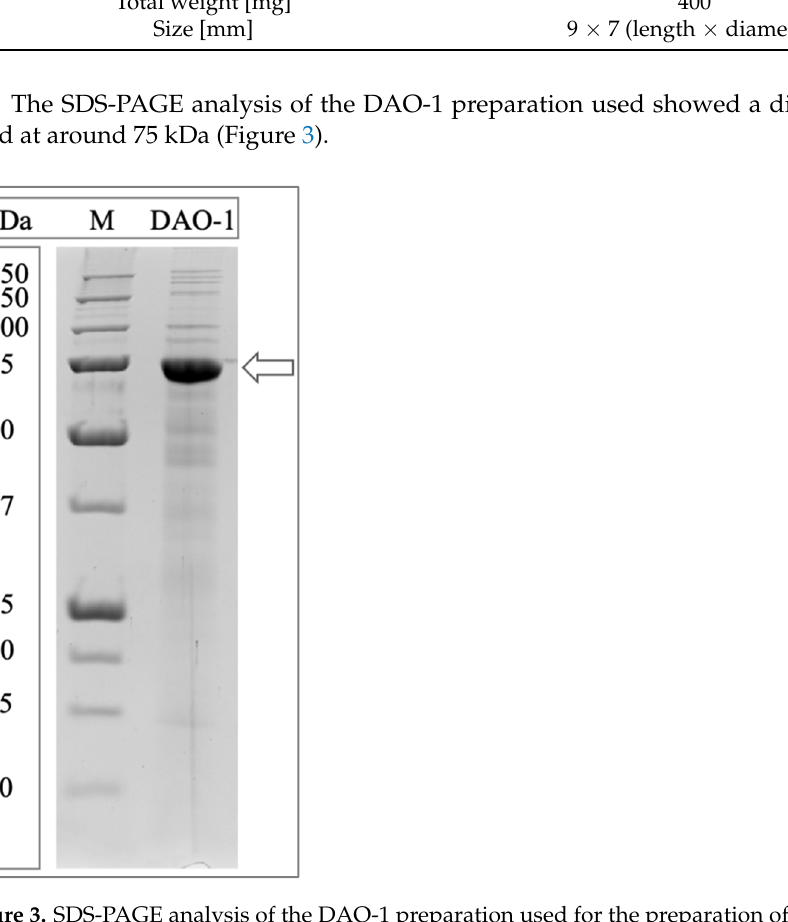
Figure 3. SDS-PAGE analysis of the DAO-1 preparation used for the preparation of DAO-1 tablets. Precision Plus Protein™ unstained protein standard 10–250 kDa (M). Arrow indicates the DAO-1 protein